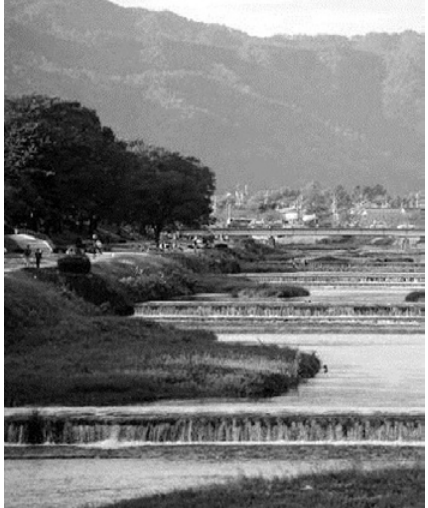
Figure 8. Kamo River landscaping, Kita guard Source: Taken by the author,